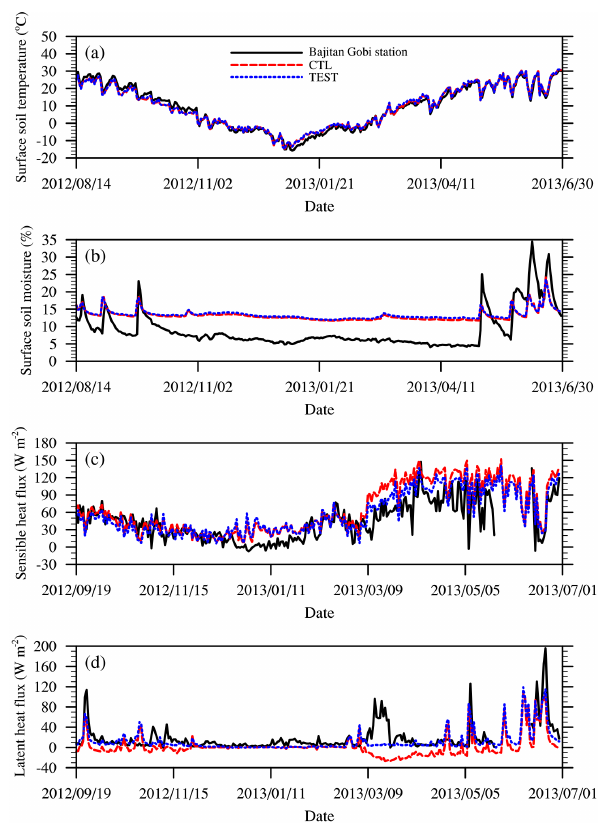
Figure 6. Time series of the observations from the eddy covariance and automatic weather station systems and results from the CTL and TEST simulations at Bajitan Gobi station for (a) surface soil temperature, (b) surface soil moisture, (c) sensible heat flux, and (d) latent heat flux.